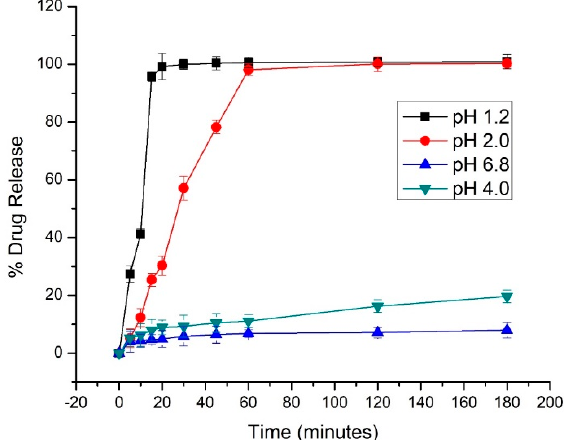
Figure 7. Release profiles of VLP in buffer (pH 1.2, 2, 4 & 6.8). Error bars indicate the standard deviation ( n = 3).